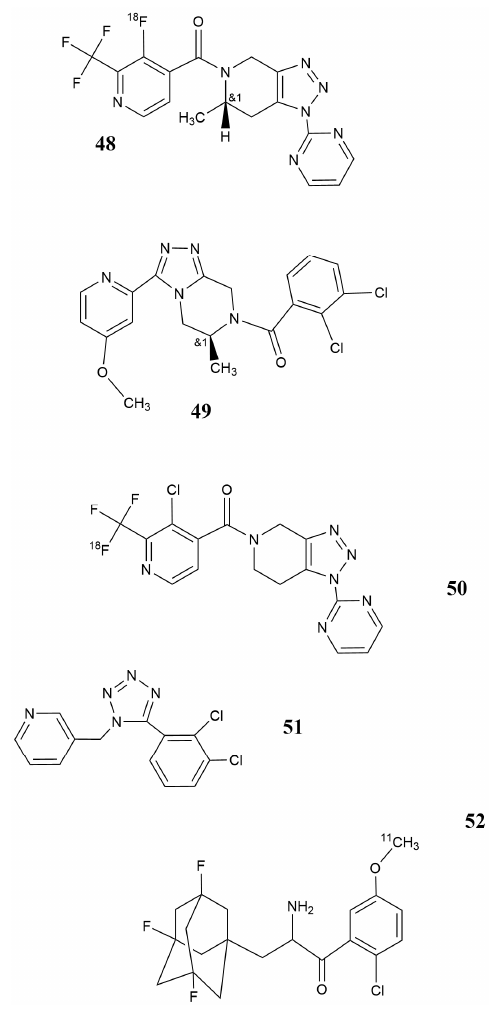
Figure 11. P2X7 receptor ligands 48 : [ 18 F] JNJ-64413739; 49 : JNJ54173717; 50 : [ 18 F]-PTTP; 51 : A438079; 52 : SMW139.